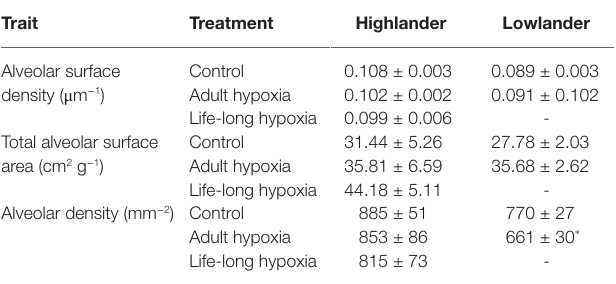
TABLE 2 | Histological measurements of lung morphology.